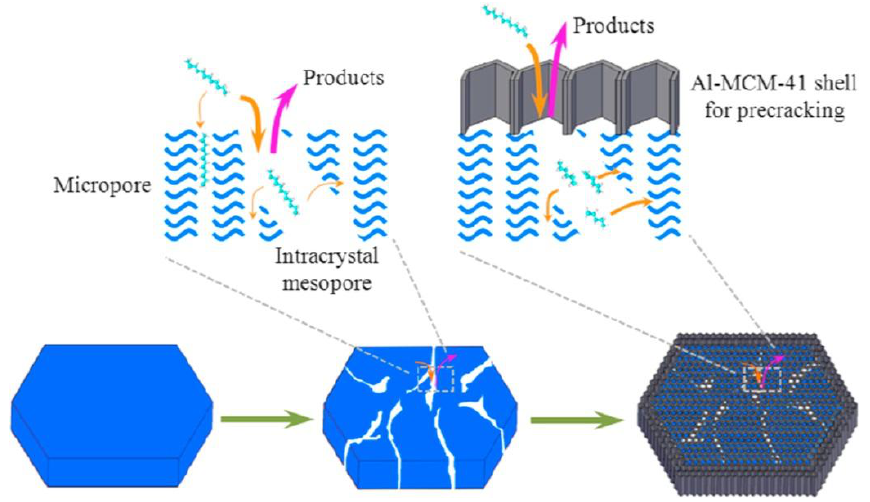
Figure 3. A schematic diagram of catalytic cracking of hydrocarbon over meso-HZSM-5@Al-MCM-41 zeolite [26]. Copyright Elsevier, 2015.